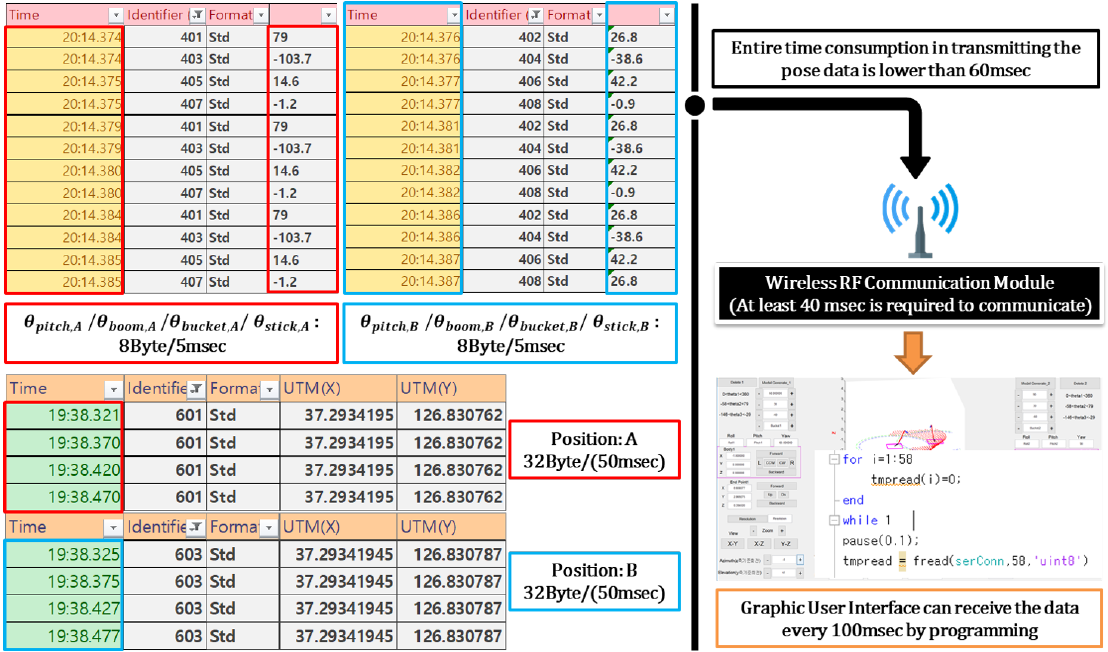
Figure A1. Entire processing time to create the obstacle in the user